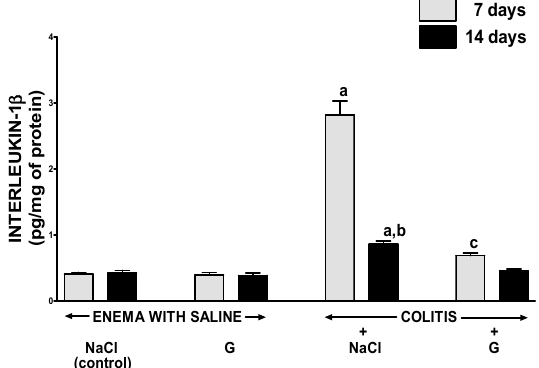
Figure 5. Effect of intraperitoneal administration of saline (NaCl) or ghrelin (G) on concentration of interleukin-1 β in colonic mucosa after seven or 14 days from enema with saline or colitis induction. Mean value ± SEM. n = 8 animals in each group. a p < 0.05 compared to control at the same time of observation; b p < 0.05 compared to a value observed at the same group after seven days from colitis induction; c p < 0.05 compared to rats with colitis treated with NaCl at the same time of observation.